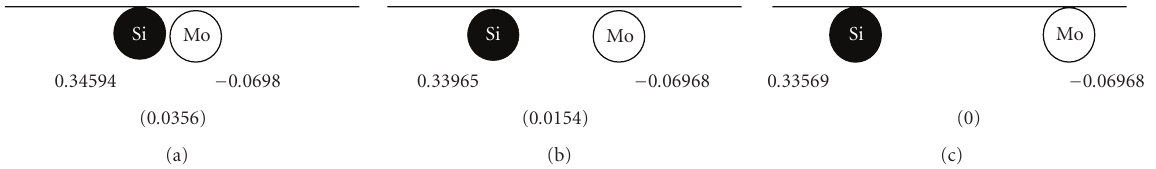
Figure 4: Energetics of the computational cell as a Si atom (black disk) goes from the Al (open circle) matrix to the U (grey circles) fuel. The chemical and total energy contributions of the Si atom are shown in each case in a thick rectangle. The total energies of U or Al atoms are indicated in dashed and thin rectangles, respectively. The di ff erence in energy (in eV) with respect to the lowest energy state (left top corner) is noted below each graph.